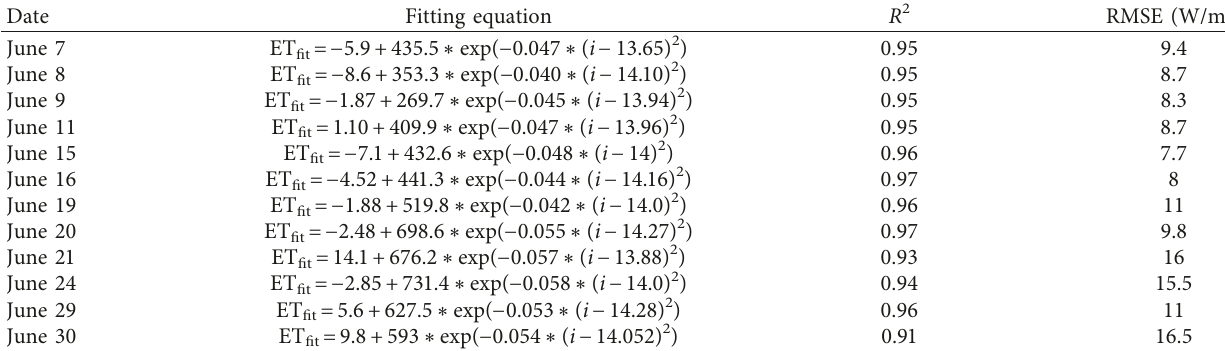
Table 3: Gaussian fitting results on ET measurements at EC10 on cloud-free days in June 2012.